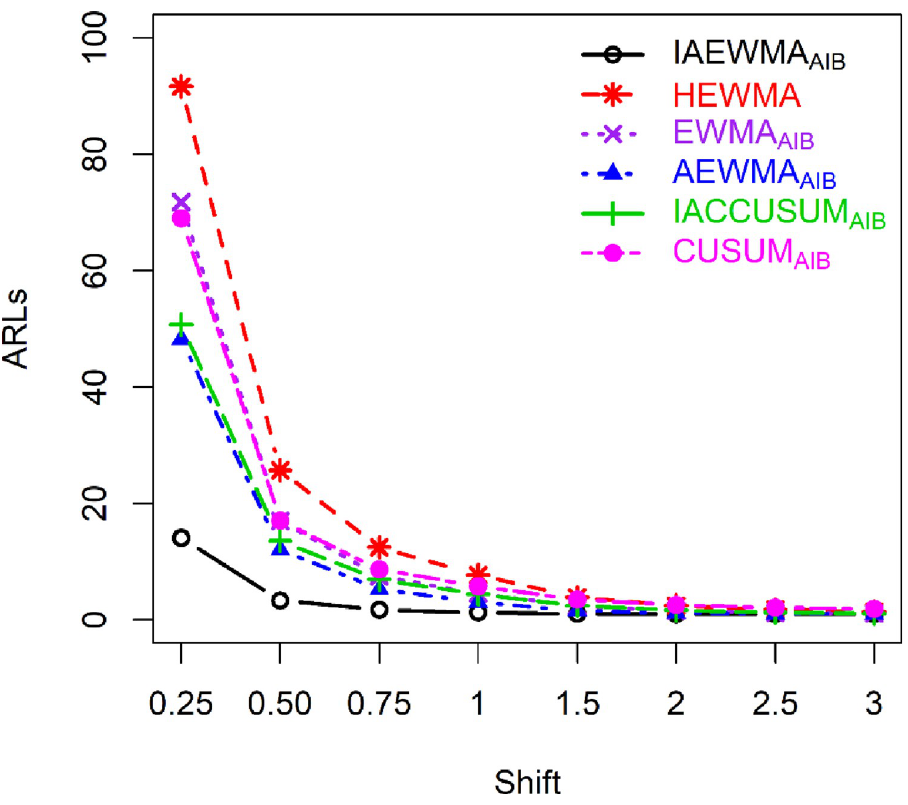
Fig 2. ARL profile of IAEWMA AIB , HEWMA, EWMA AIB , AEWMA AIB , IACCUSUM AIB , and CUSUM AIB control charts at ρ = 0.75, ( λ , λ 2 ) = 0.20, λ 1 = 0.10 when ARL 0 = 500.